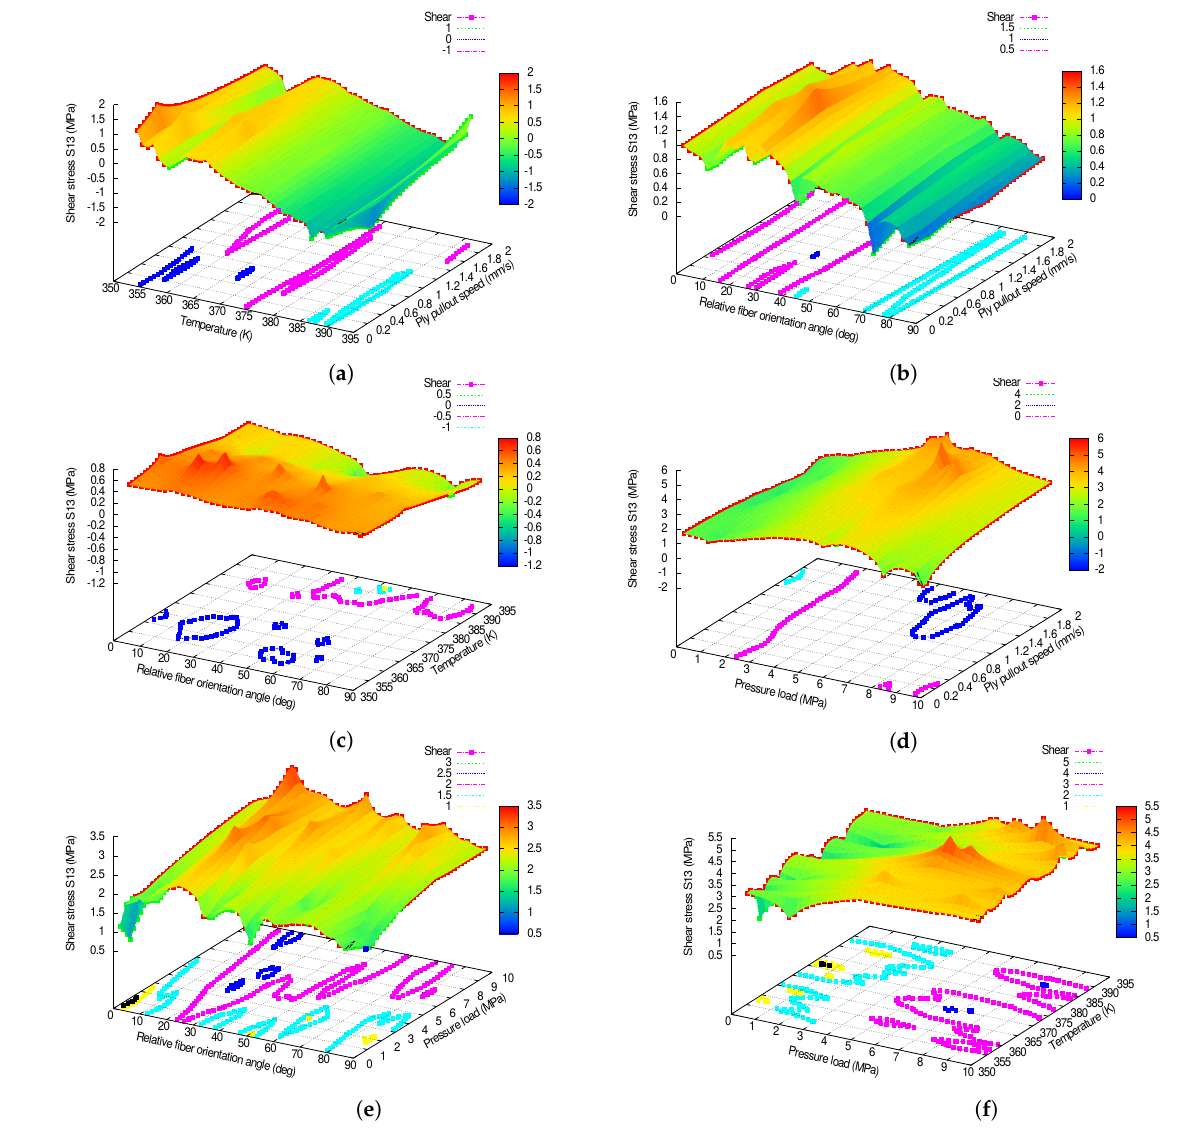
Figure 4. Surface plots of inter-ply shear stress versus paired parameters. ( a ) Surface Plot 1. ( b ) Surface Plot 2. ( c ) Surface Plot 3. ( d ) Surface Plot 4. ( e ) Surface Plot 5. ( f ) Surface Plot